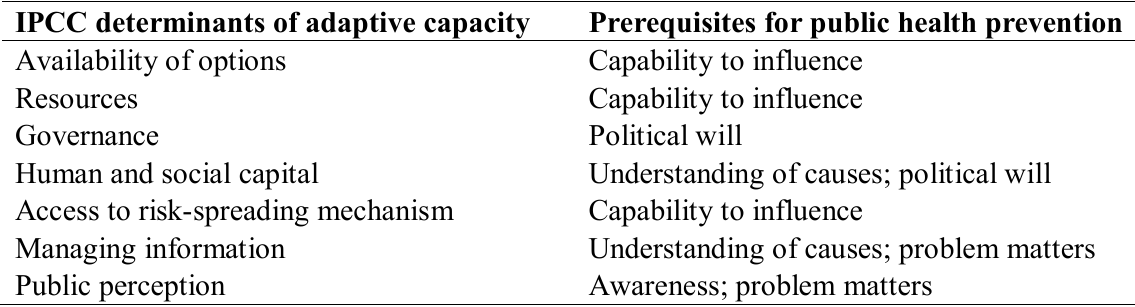
Table 1. Effective public health activities with corresponding IPCC determinants of adaptive capacity